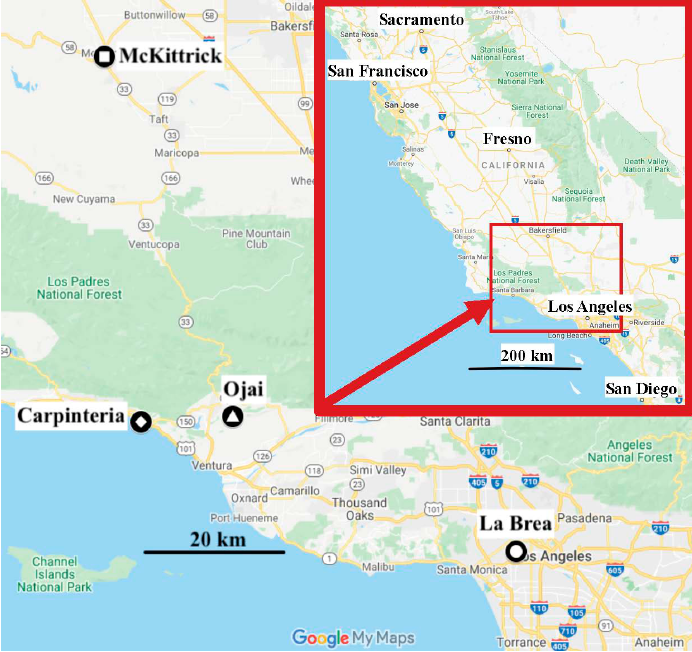
Figure 2. Map showing location of the three sampling sites plus La Brea.